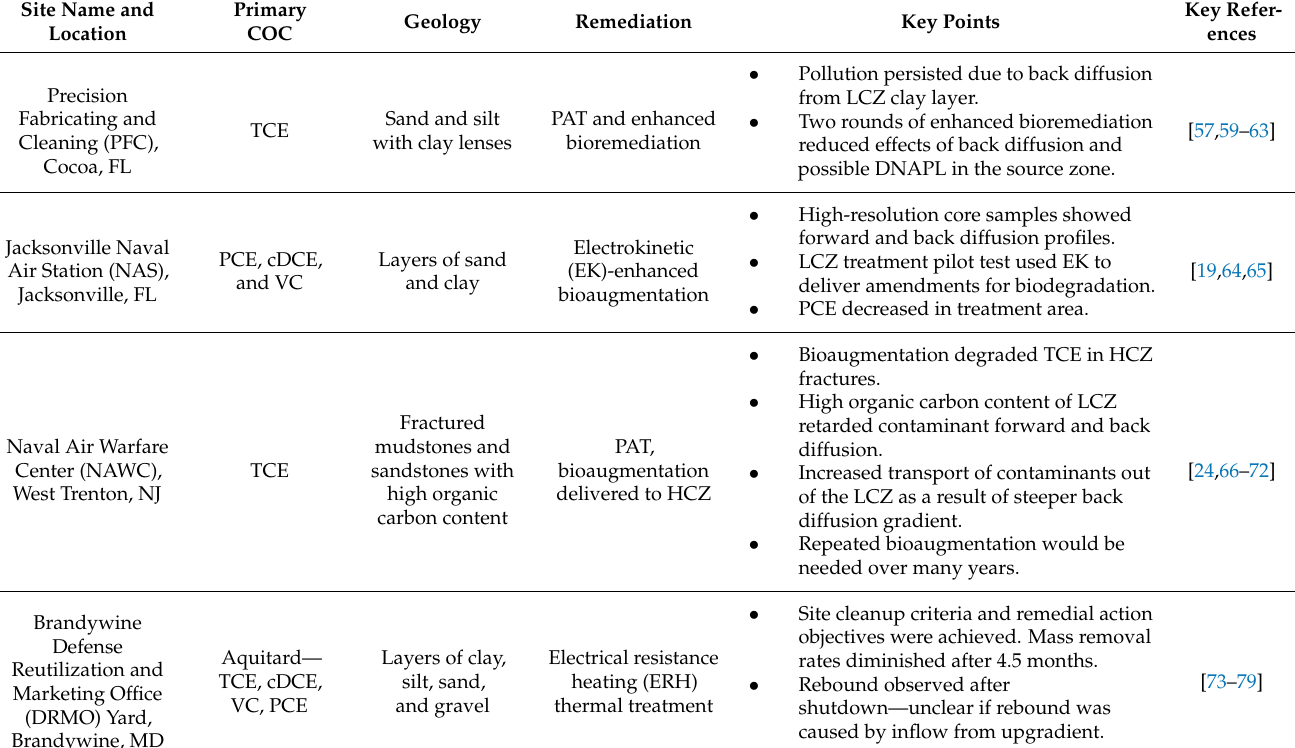
Table 2. Summary of case